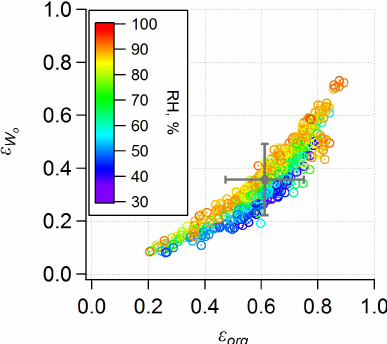
) plotted versus organic mass o = 36 ± 14%. o